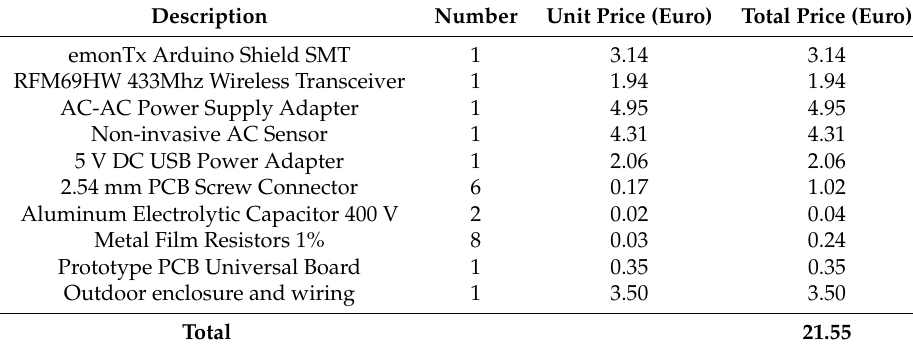
Table 4. Utility grid monitoring node cost.